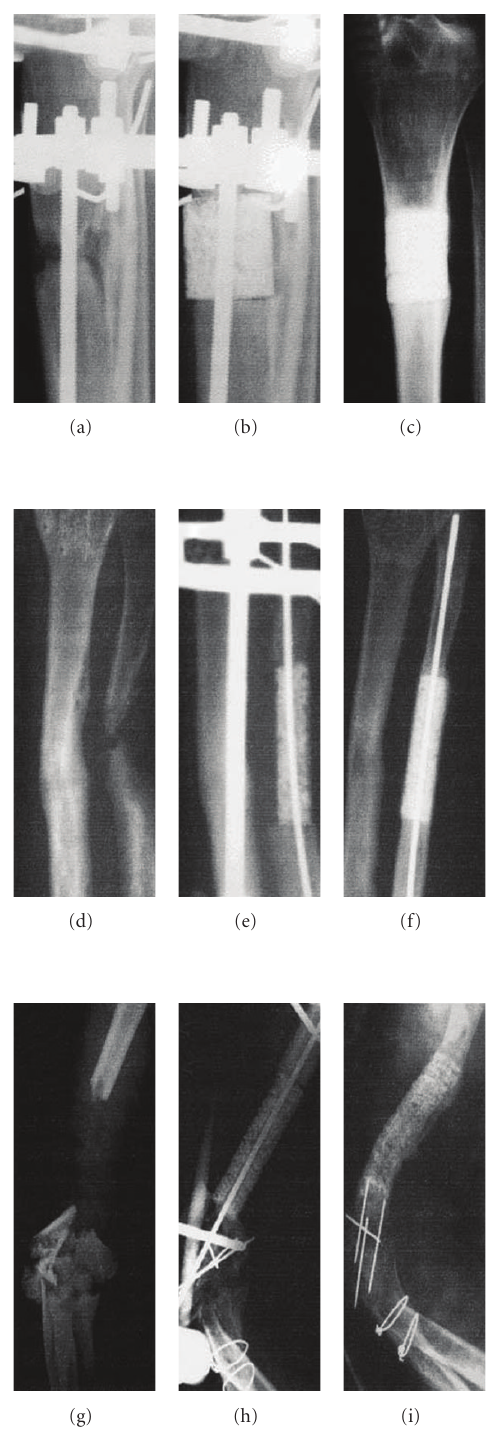
Figure 3: Radiographs obtained before and after the repair of large bone defects in three Patients from the study by Quarto et al. panels (a)–(c) show films obtained from Patient 1 before, immediately after, and 18 months after surgery, respectively. Panels (d)–(f) show films from Patient 2 before, immediately after, and eight months after surgery, respectively. Panels (g)–(i) show films from Patient 3 before, immediately after, and 15 months after surgery, respectively. All the films obtained at the last time point demonstrate bridging of the defect with newly formed